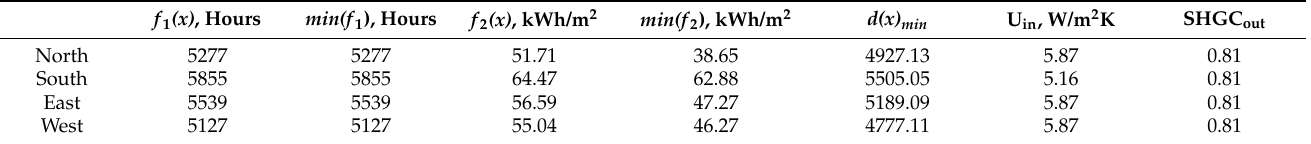
Table 9. Summary of numerical outcomes for the optimal